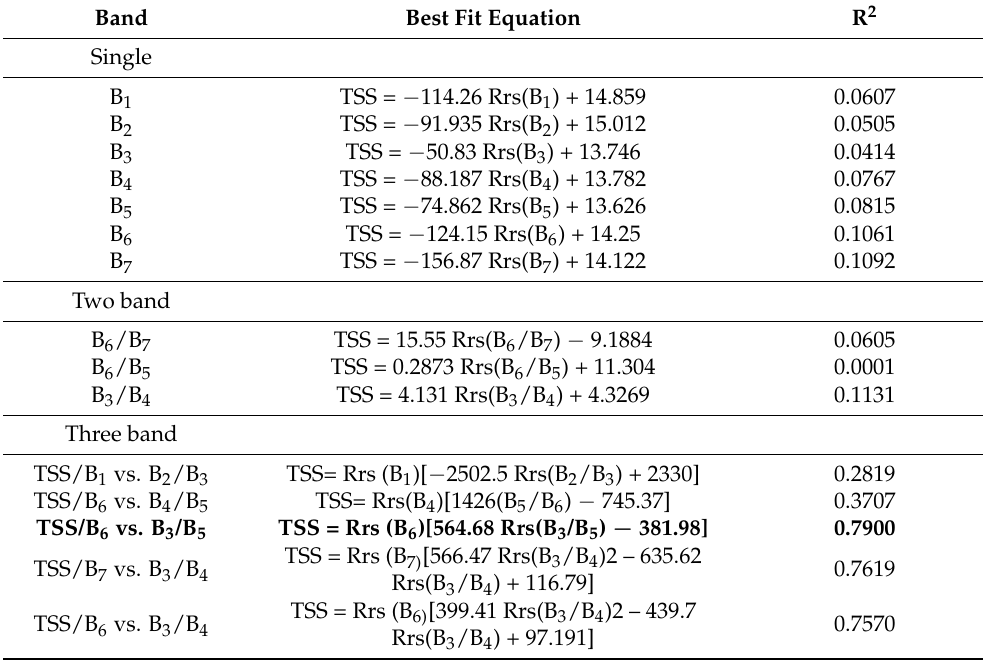
Table 3. Regression results of TSS against several Landsat 8 bands. B 1 -B 7 represent the designated band of Landsat OLI. The wavelength for seven spectral Landsat bands (B 1 –B 7 ) used in this study are 0.43–0.45, 0.45–0.51, 0.53–0.59, 0.64–0.67, 0.85–0.88, 1.57–1.65 and 2.11–2.29 µ m,